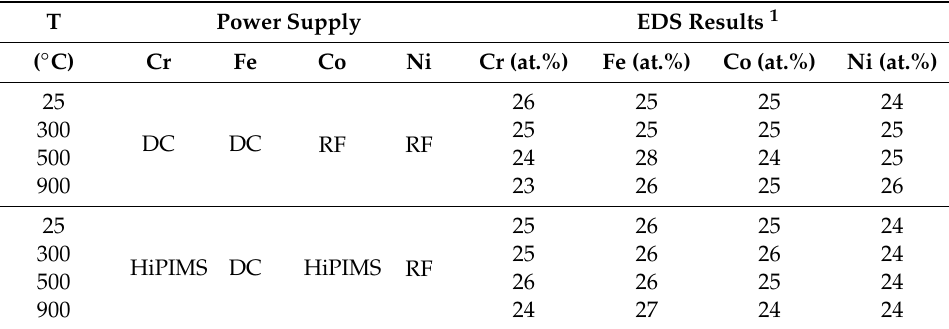
Table 1. Overview of sputter conditions and resulting thin film compositions.